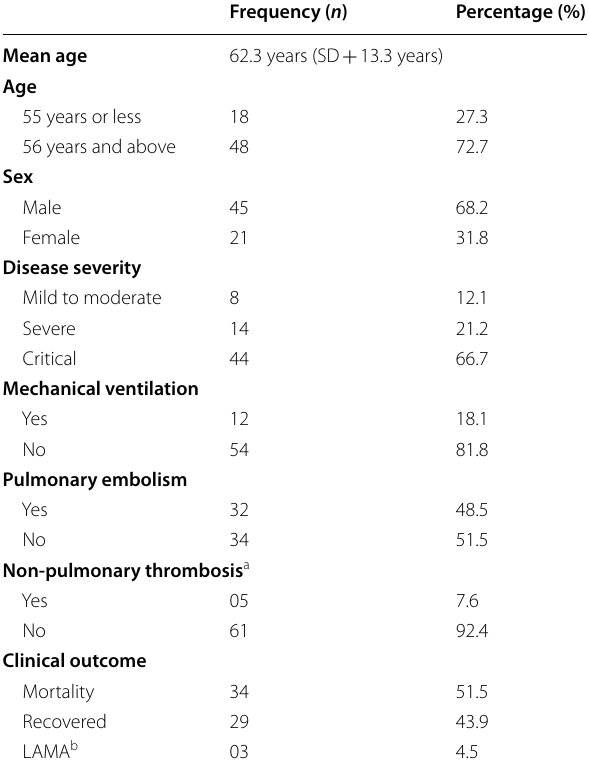
Table 1 Demographics and clinical characteristics of COVID-19 patients ( n =